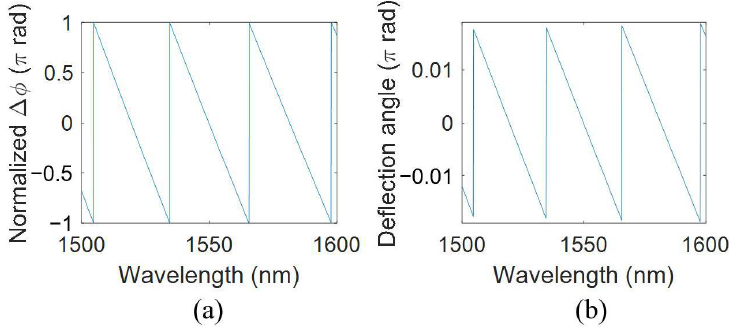
Figure 6. ( a ) Normalized phase difference Δ φ and ( b ) deflection angle θ of WSL2.